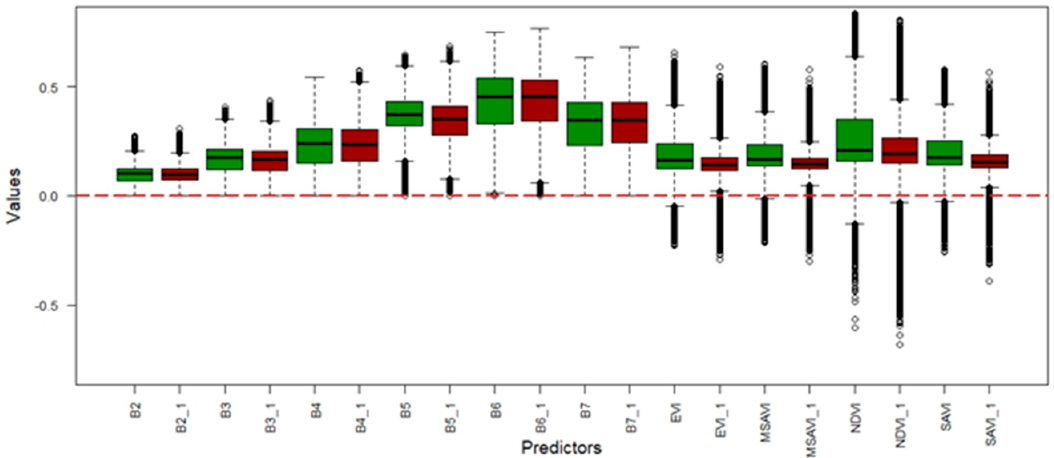
Figure 4. Predictor variables used to train the Random Forest models, showing wet-season averages (green) and dry-season averages (red) for Landsat surface reflectance (SR; bands 2–7) and vegetation index band combinations, averaged across the West African domain (Figure 5). Mean, standard deviation, percentiles, and outliers are as noted for Figure 3.